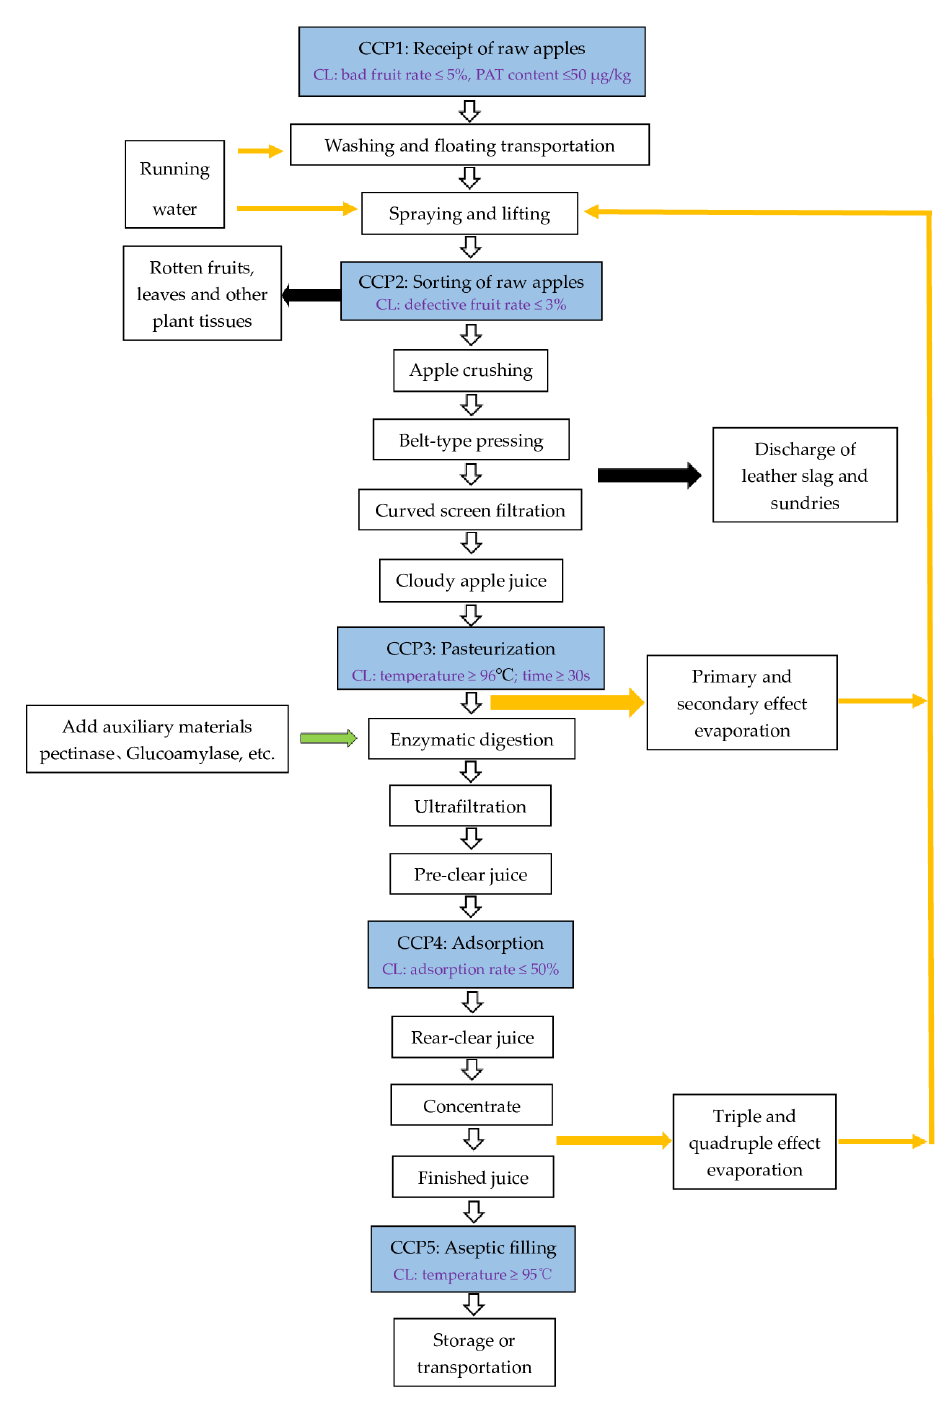
Figure 1. Process flow chart for apple juice concentrate. Abbreviations: CL—critical limits. (Processes in blue box represent critical control points, processes indicated by black arrow represent waste, processes pointed by yellow arrow represent water cycle, and processes indicated by green arrow represent auxiliary material addition).